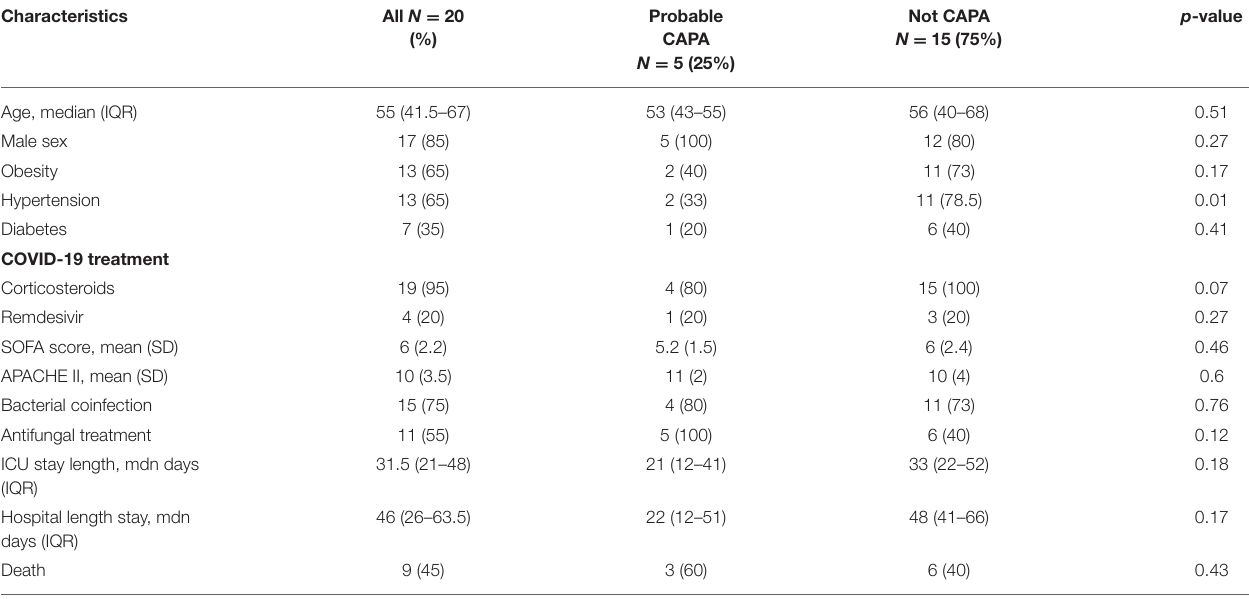
TABLE 1 | Clinical characteristics of critically ill patients with COVID-19 along with probable COVID-19-associated pulmonary aspergillosis (CAPA). Characteristics All N = 20